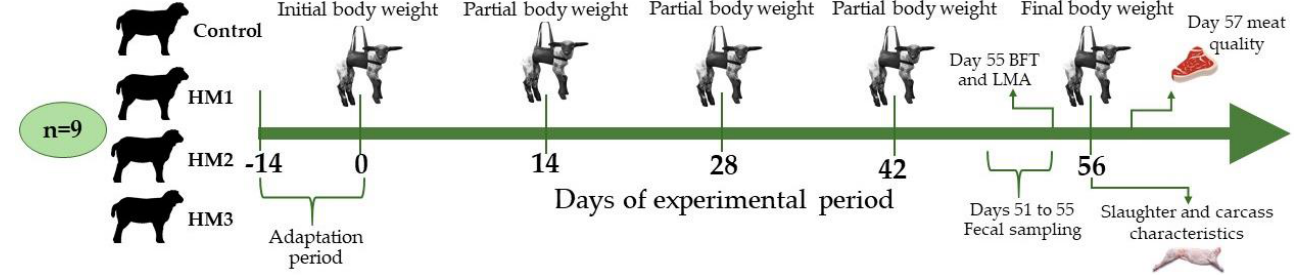
Figure 1. Completely randomized design and sampling times of lambs supplemented with a polyherbal mixture (HM) during the final fattening period; n = 9 — indicate the number of animals sampled in each treatment; Control — basal diet without HM; HM1 — basal diet + 1 g of HM kg − 1 of dry matter (DM); HM2 — basal diet + 2 g of HM kg − 1 of DM; HM3 — basal diet + 3 g of HM kg − 1 of DM; BFT — backfat thickness; LMA — longissimus muscle area.